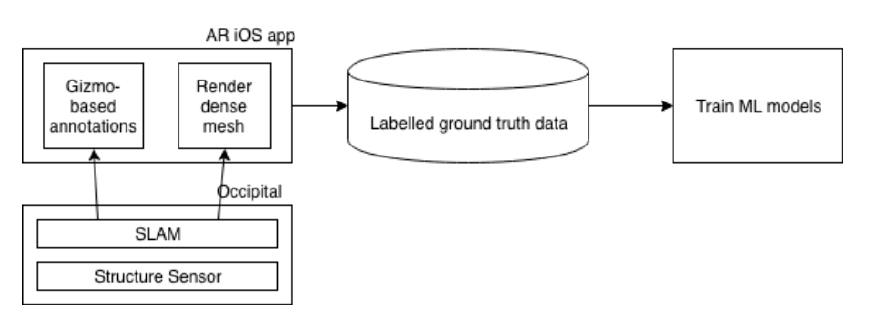
Figure 4: Overview of Augmented Annotations.